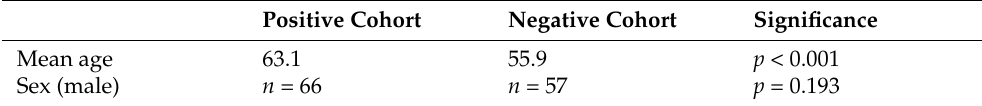
Table 2. Overview of patient characteristics in the test cohort.